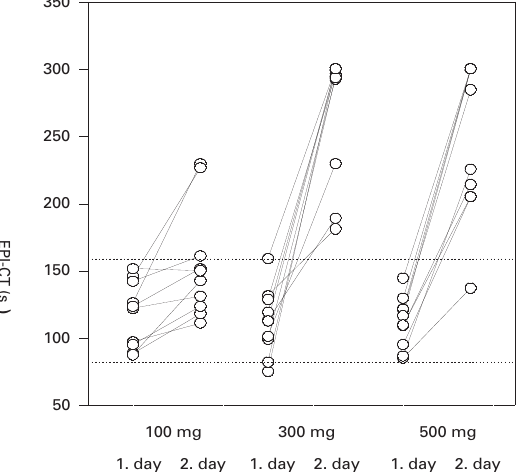
Figure 1 Influence of a single dose of ASA on EPI- CT. EPI-CT was mea- sured in healthy sub- jects, before (1 day) and 24 h after (2 day) ingestion of 100 mg (n = 10), 300 (n = 10) or 500 mg of ASA (n = 10). Horizontal dotted lines show upper and lower normal ranges for